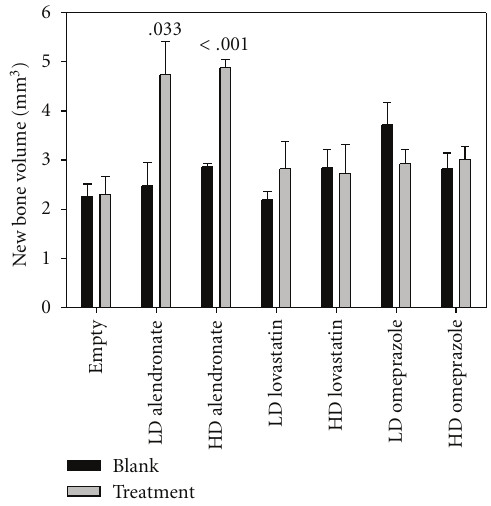
Figure 3: New Bone Volume Quantified from the MicroCT Analysis (mm 3 ). The volume of new bone (mm 3 ) formed in each treatment group (gray bars) was compared to the volume of new bone formed in the contralateral, blank-treated femurs (black bars) for that group using Students t -tests. Significant P -values are shown (LD: low-dose; HD: